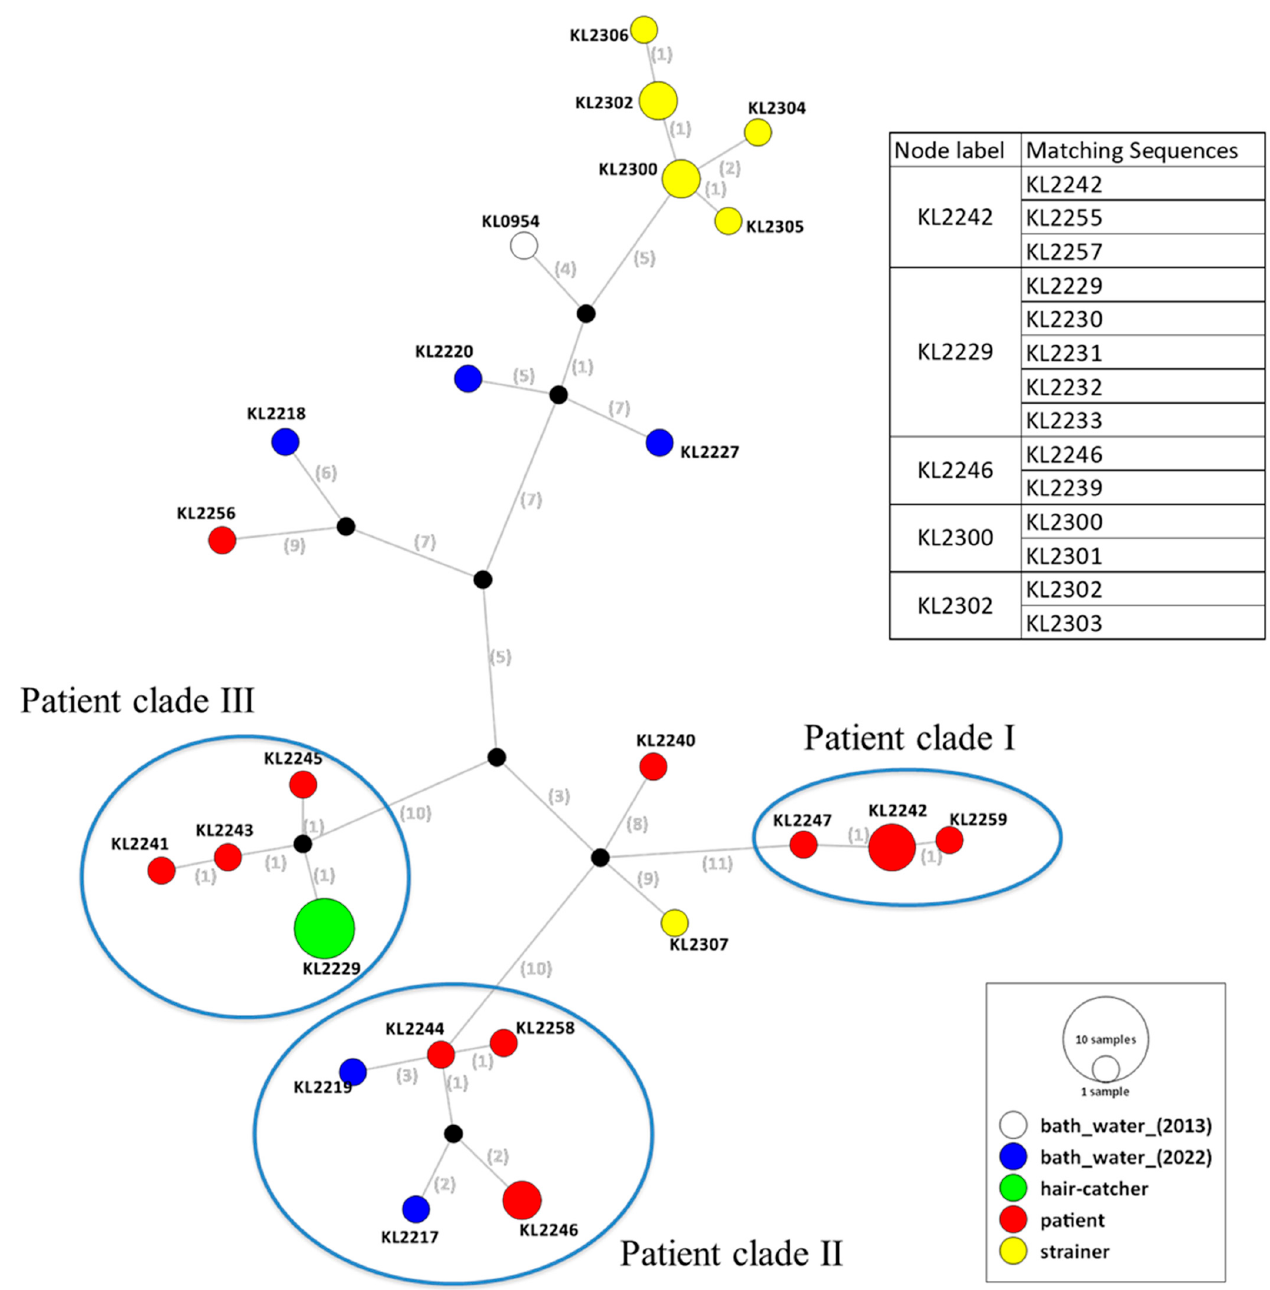
Figure 1. Haplotype network analysis based on single-nucleotide variants (SNVs) using whole-genome sequencing of 33 Legionella pneumophila serogroup 1 (SG1) sequence type (ST) 138 strains. The numbers between each node represent the number of SNVs. The strains isolated from the patient and environmental samples, bath water, hair catcher and filtration are shown as red, blue, green and yellow circles, respectively. KL0954 isolated from bath water in 2013 is indicated as white circle. The raw sequence data used in this study were deposited in DDBJ/EMBL/GenBank under DRA accession number DRR410368-DRR410400.